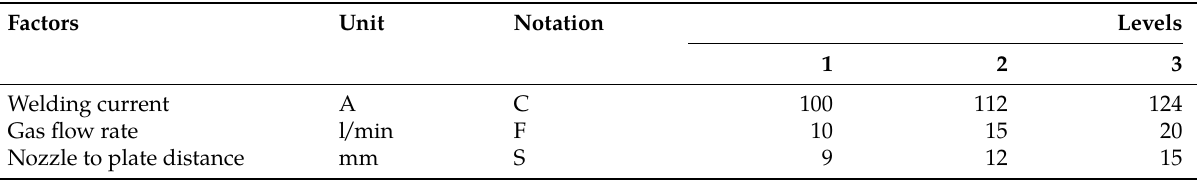
Table 1: Welding process parameters and their levels.